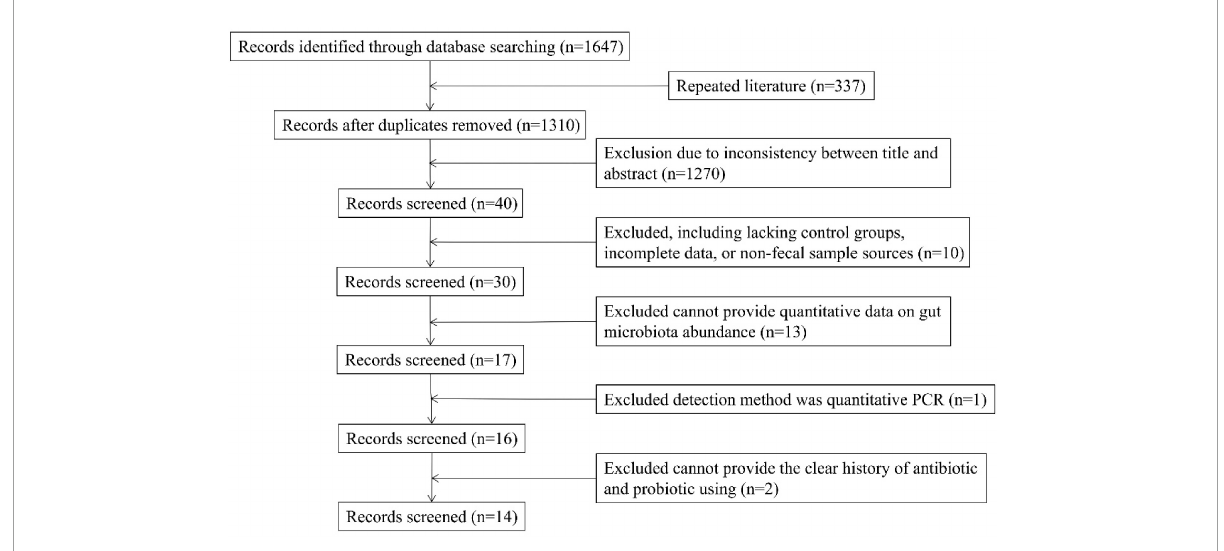
FIGURE1 Flow diagram of the assessment of studies used in the meta-analysis.